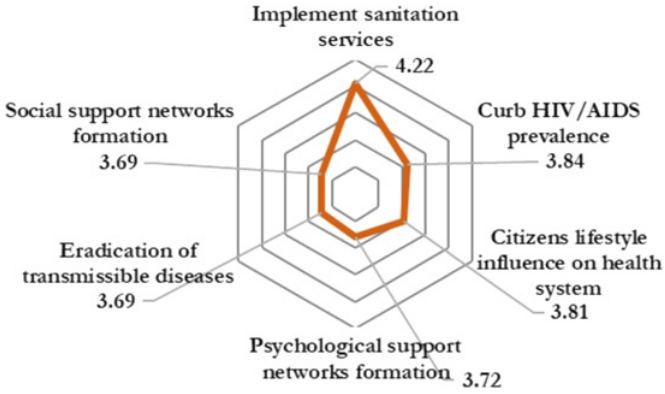
Influence of Healthcare System on Resilience